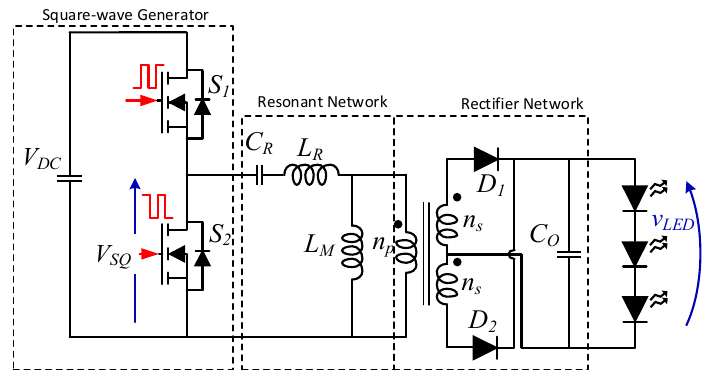
Figure 4. Half ‐ bridge LLC resonant converter topology.